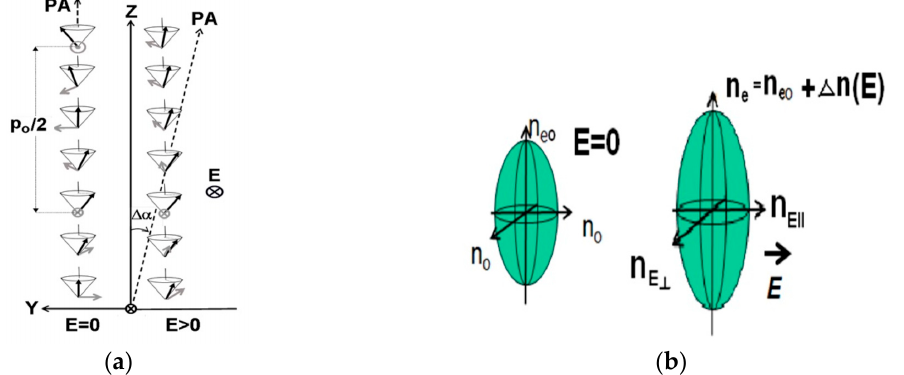
Figure 15. ( a ) Illustration of the deflection of principal axis in the presence of electric field. ( b )